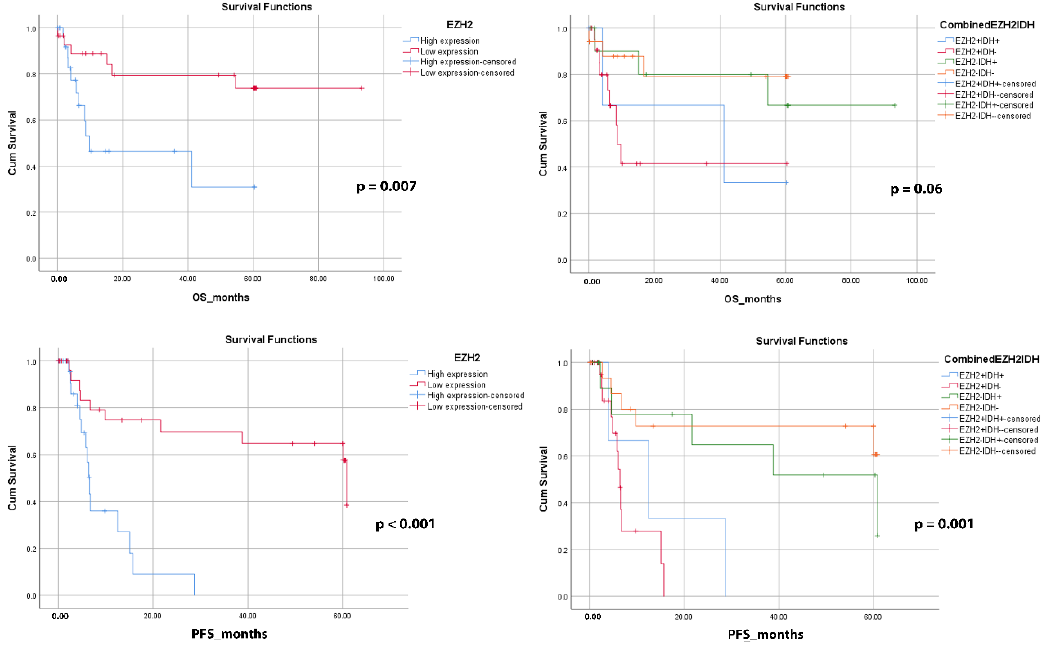
Figure 2. Kaplan–Meier survival curves for 5-year overall survival and 5-year progression-free survival in glioma patients according to EZH2 and combined EZH2/IDH1 immunoexpression status. Abbreviations: PFS, progression-free survival; OS, overall survival.